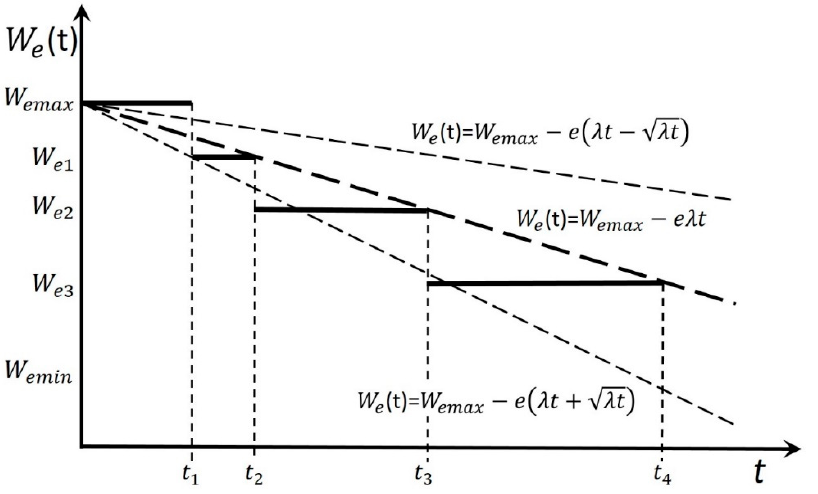
Figure 5. Graphic interpretation of the example realization of the reduction of the useful work of engine: W e —useful work, e —quantum by which the work of W e is changed the engine: 𝑊 (cid:3032) —useful work, e —quantum by which the work of 𝑊 (cid:3032) is changed [6,7].